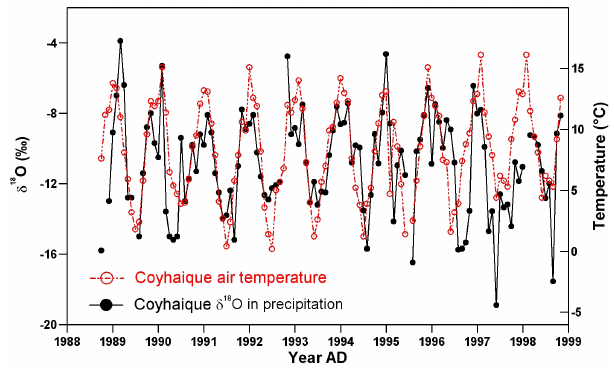
Fig. 5. Relationship between δ 18 O in precipitation and air temperature at the GNIP station Coyhaique (45°21’00’’S, 72°4’12’’W, 310 m a.s.l.) (IAEA/WMO, 2006).